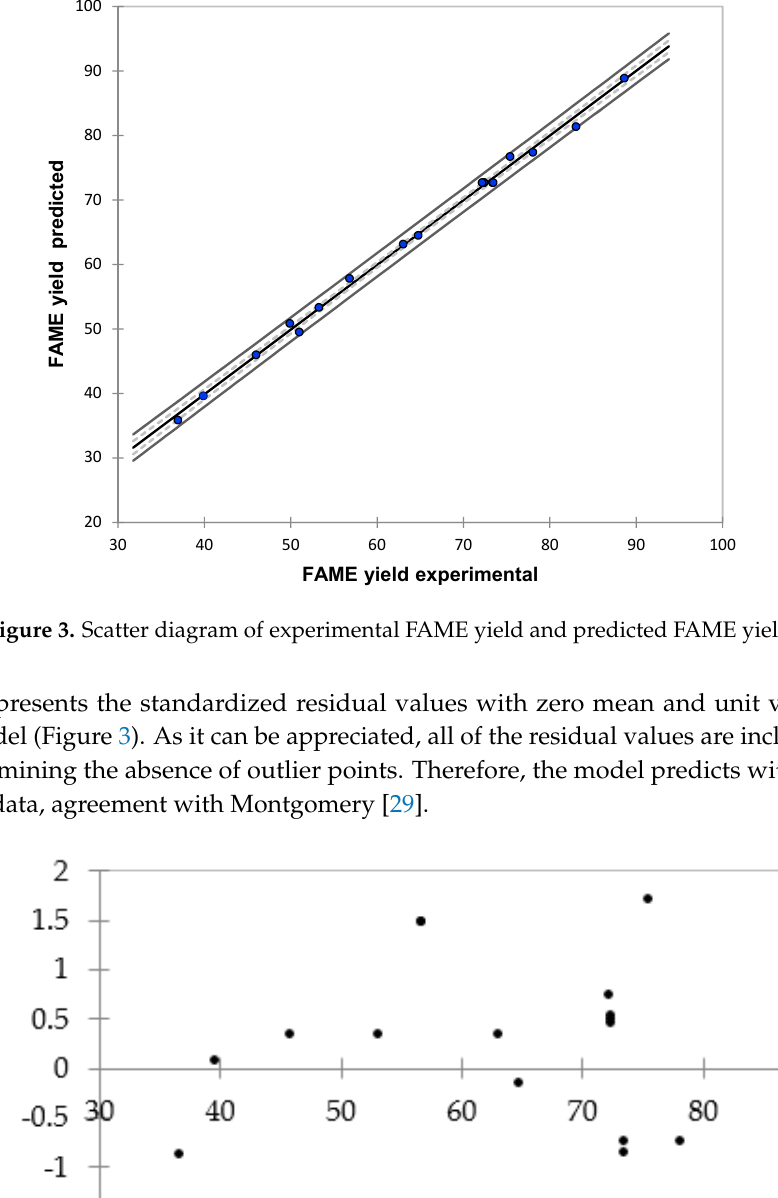
Table 6. ANOVA for the model regression.